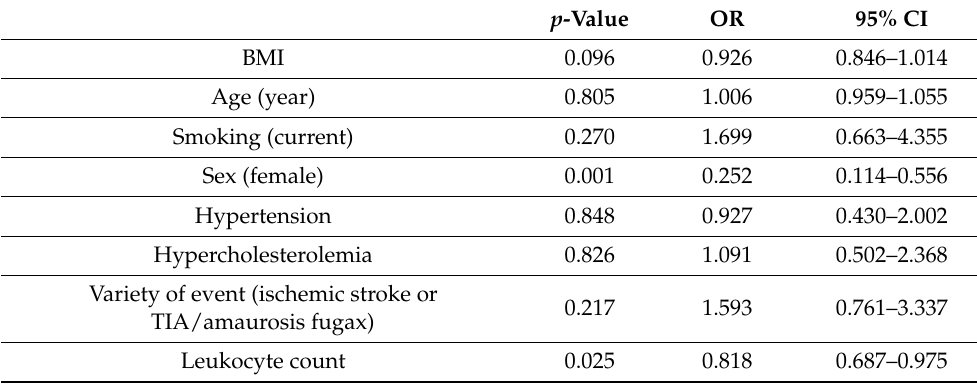
Table 5. Multivariate logistic regression analysis for LRNC with leukocyte count, corrected for other